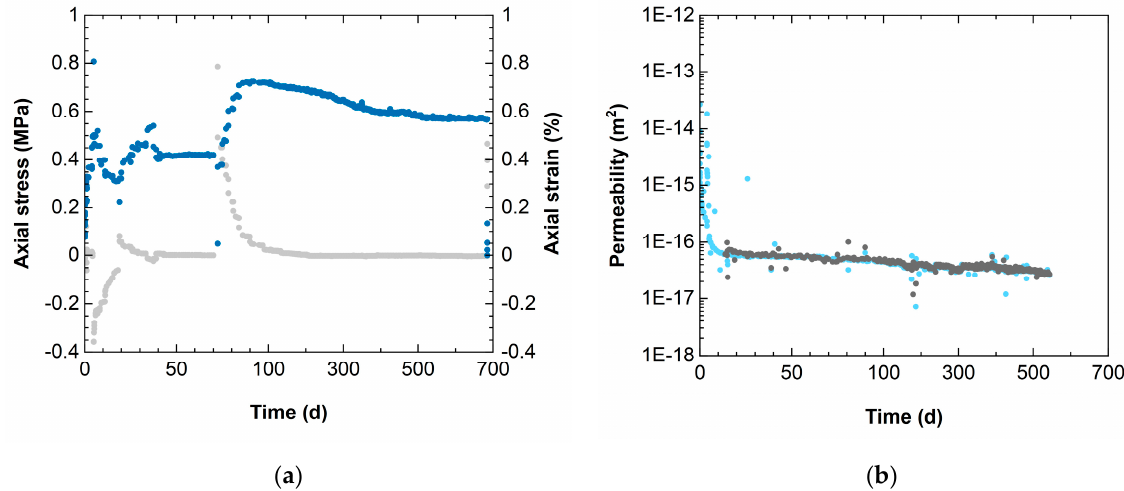
Figure 3. ( a ) Axial strain (grey) and axial stress (blue) and ( b ) inflow (blue) and outflow (grey) permeability cell 10.